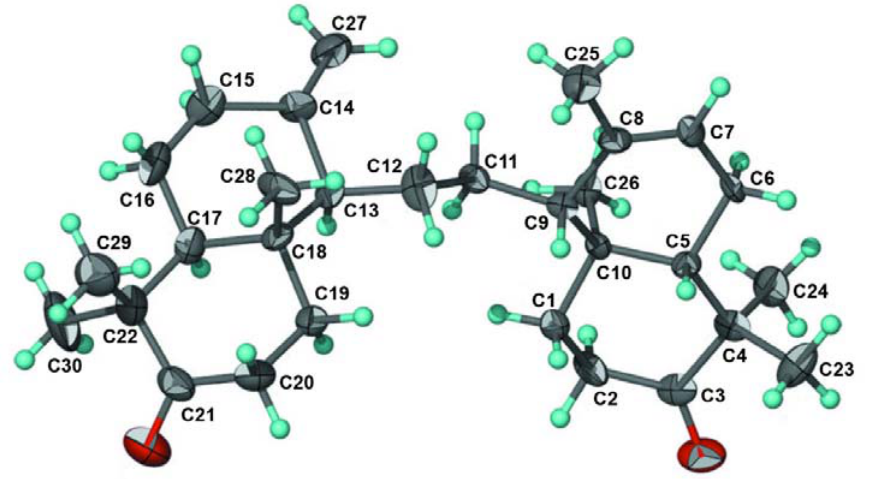
Figure 6. ORTEP drawing for 5 reproduced from Tjokronegero et al.